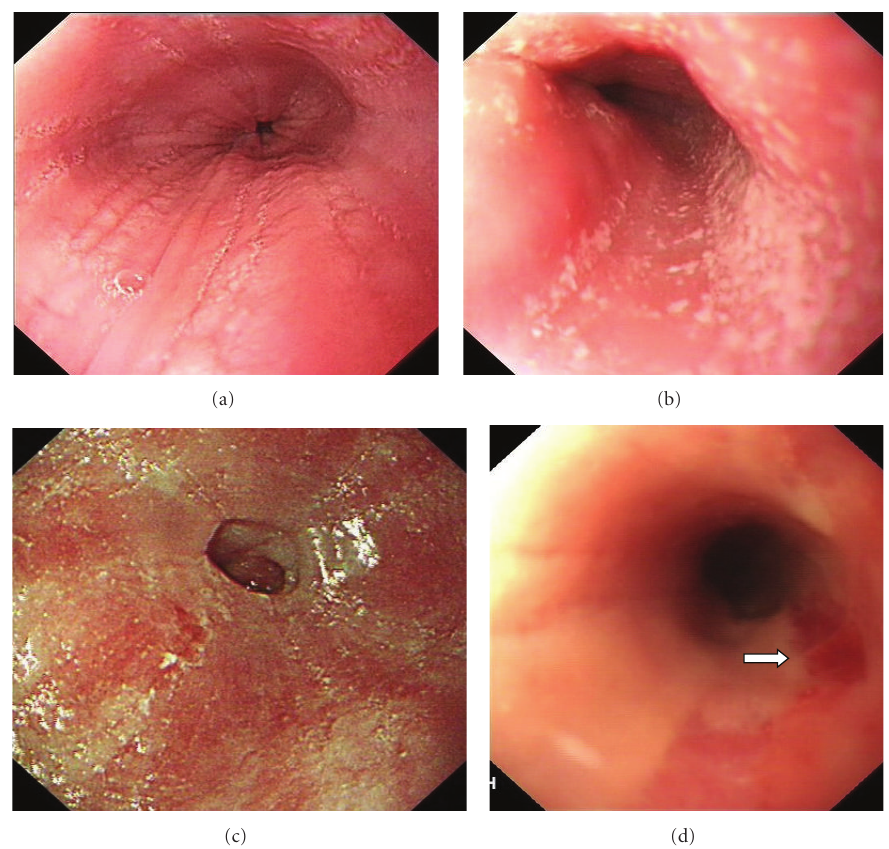
Figure 1: Endoscopic abnormalities seen in our patients. (a) Longitudinal furrows and edema giving the wrinkled appearance (patient 12). (b) Patchy specks or exudates mimicking esophageal candidiasis (patient 13). (c) Ring stricture at the lower esophagus (patient 14). (d) Crepe-paper mucosa in a narrow lumen esophagus (arrow) (patient